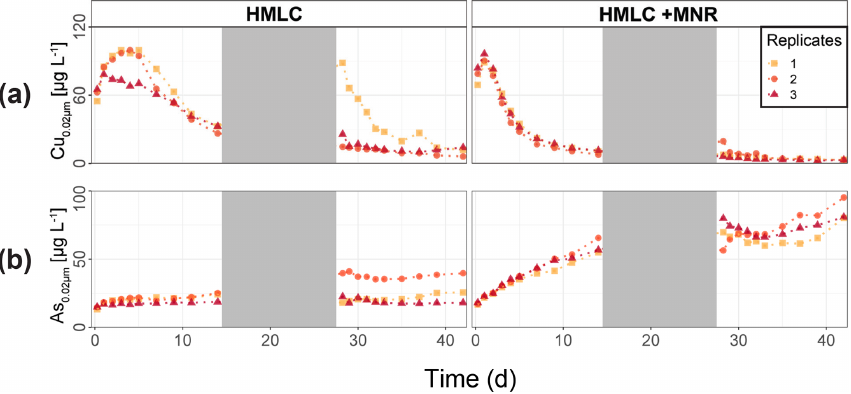
Figure 4. Soil solution dynamics in cornfield soil (HMLC) incubations for Cu (a) and As (b) . Lines between points were plotted to improve readability. The gray area indicates the drained